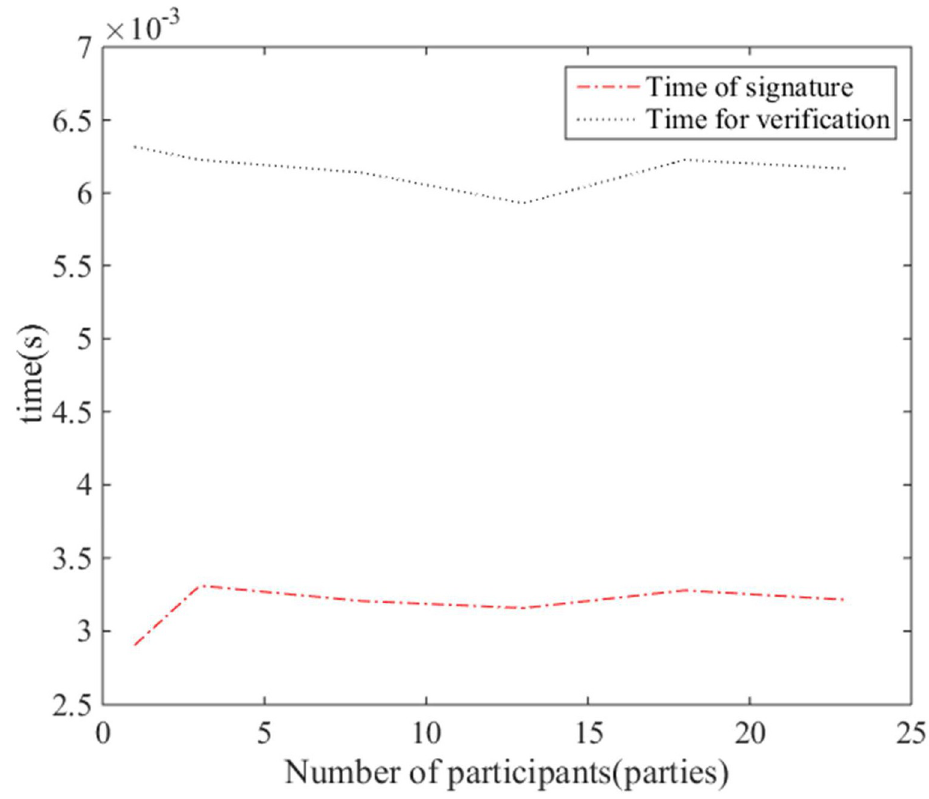
Fig 10. Average runtime of SM2 scheme and multi-party co-digital signature and signature